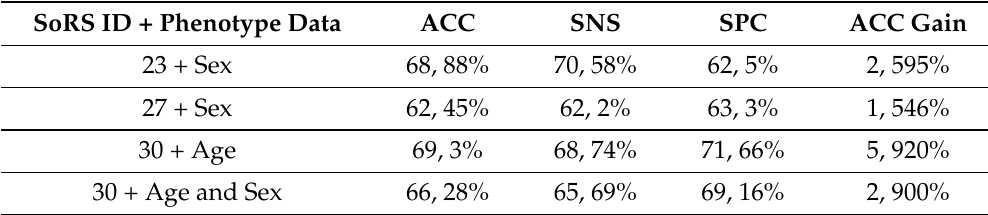
Table 12. Results adding phenotype data to the SoRs.